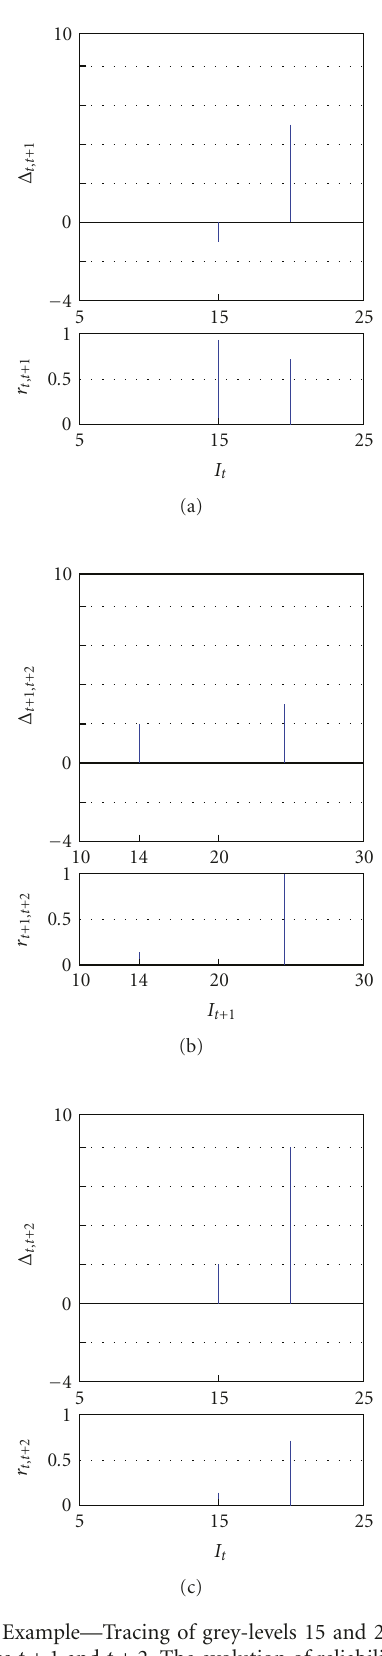
Figure 12: Example—Tracing of grey-levels 15 and 20 of frame t along frames t + 1 and t + 2. The evolution of reliability weights is also